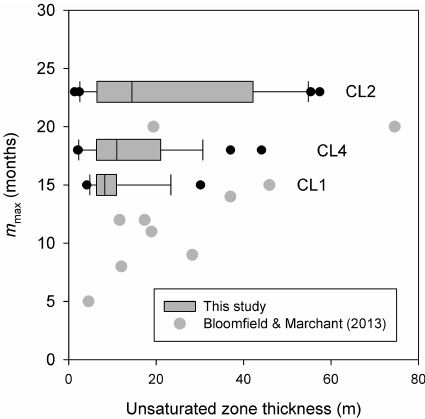
Figure 12. SGI autocorrelation ( m max ) as a function of unsaturated zone